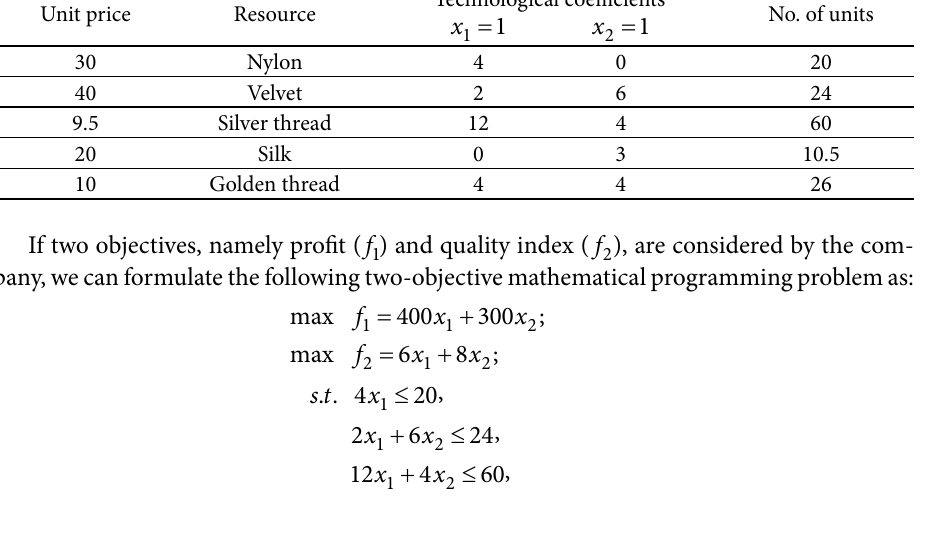
Table 1. Resource allocation of Zeleny’s example Unit